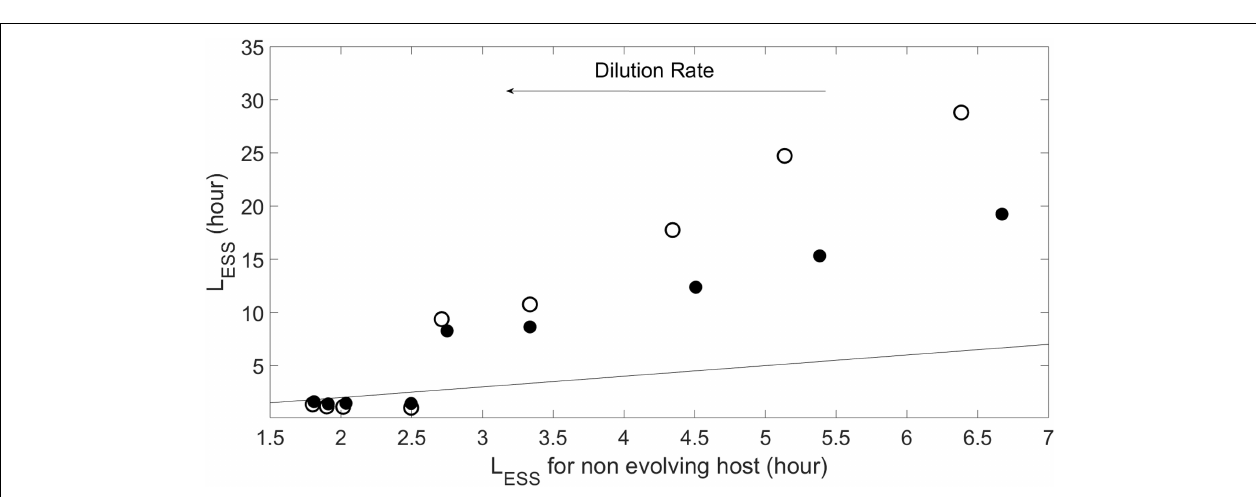
FIGURE 5 | Evolutionary stable strategy (ESS) for the virus obtained when host evolves at N 0 = 10 − 5 mol l − 1 and α = 10 − 8 lcell − 1 d − 1 , and different dilution rates as compared to the viral ESS when the host does not evolve (i.e., L = 1 / w + E ). Symbols and line as in Figure 4